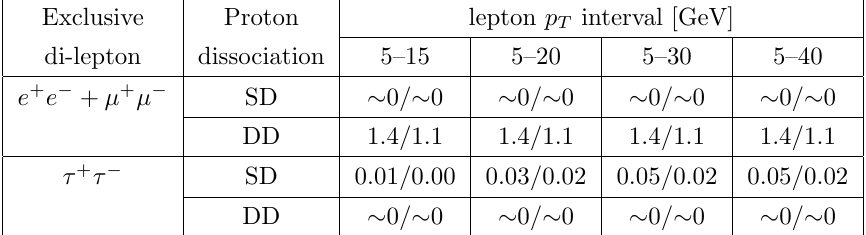
Table 5 . Event yields for an integrated luminosity of 300 fb (cid:0) 1 for di-lepton production in four lepton p T intervals after applying all cuts speci(cid:12)ed in table 2. Results for single and double proton dissociation are given, and with j (cid:17) j < 2 : 5 / j (cid:17) j < 4 : 0 intervals for the (cid:12)nal-state lepton. Lepton reconstruction e(cid:14)ciencies are taken from [15]. The purely exclusive contribution is exactly zero due to the mass acceptance of the FPDs and cuts imposed on m l , so are not shown. The l l 2